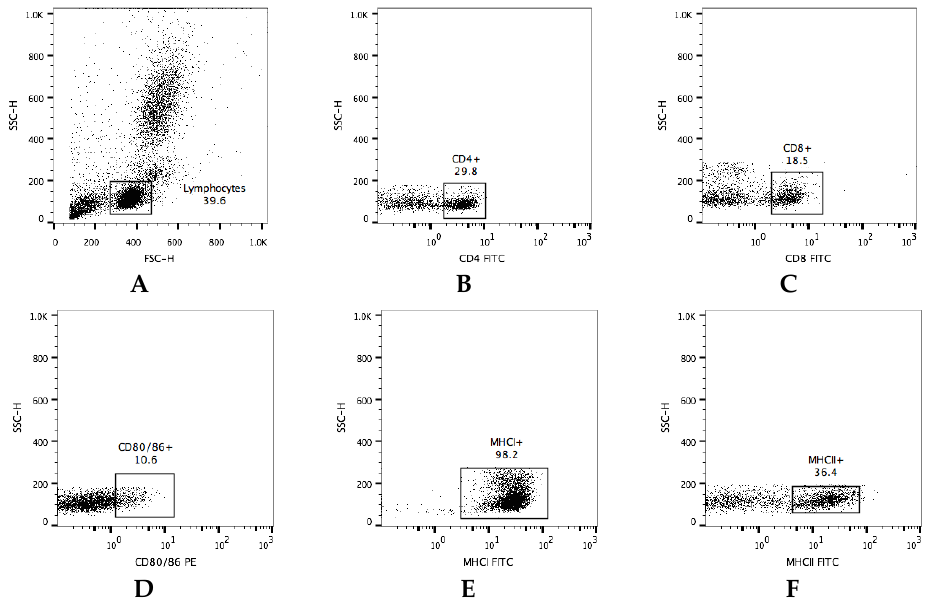
Figure 1. The detection of single nucleotide polymorphisms’ genotype distribution by ARMS-PCR. After the clean-up of PCR products, some were digested by RE, and PCR products were separated into different fragment sizes using 2% agarose gel electrophoresis to distinguish single-nucleotide variation. ( A ) Three genotypes, G/G, G/T, and T/T, in the SNP3 IFN-γ 490 gene. ( B ) Two genotypes, A/A and A/T, in the SNP19 TLR3 405 gene.